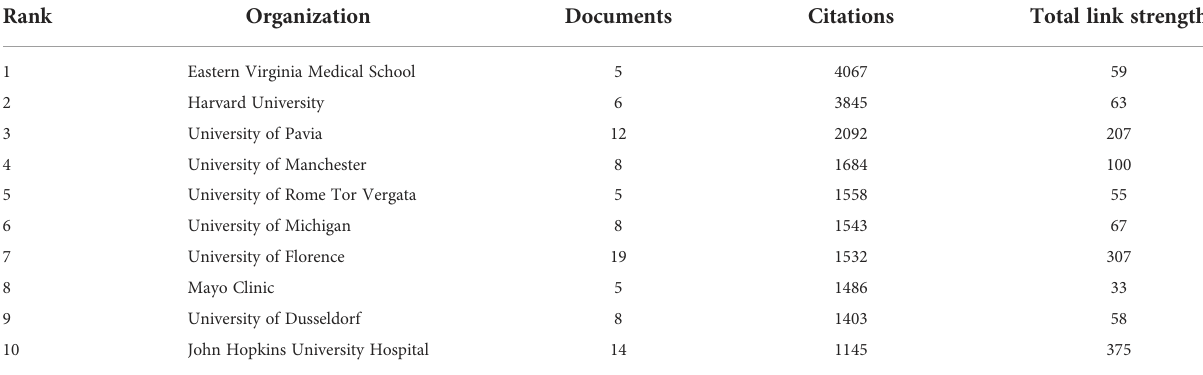
TABLE 4 The number of citations for publications on DMED by the top 10 institutions.